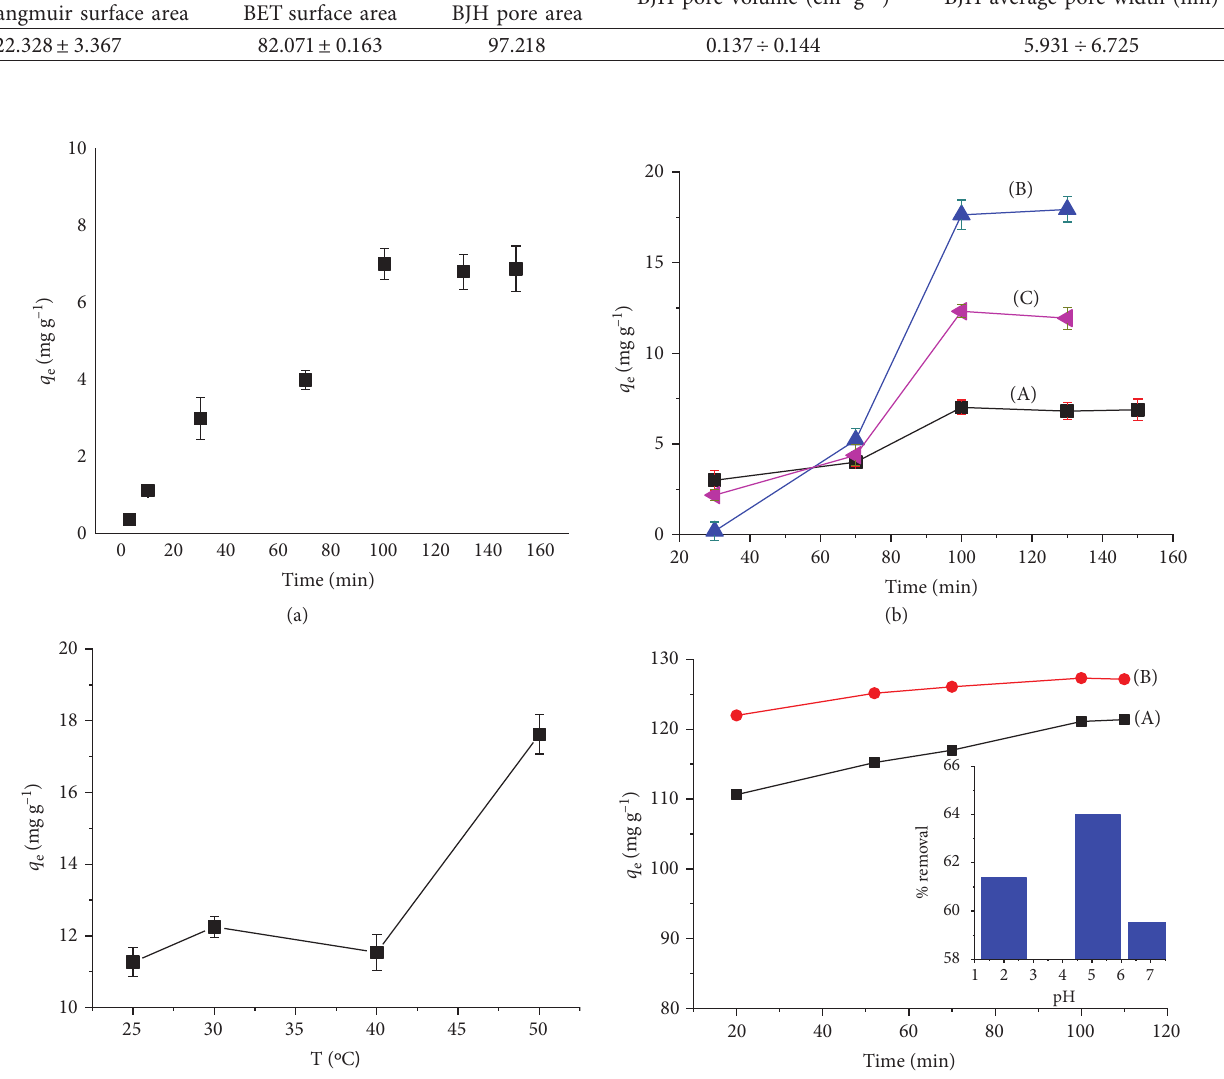
Table 1: BET surface area analysis of as-synthesized GO/PVA/Fe